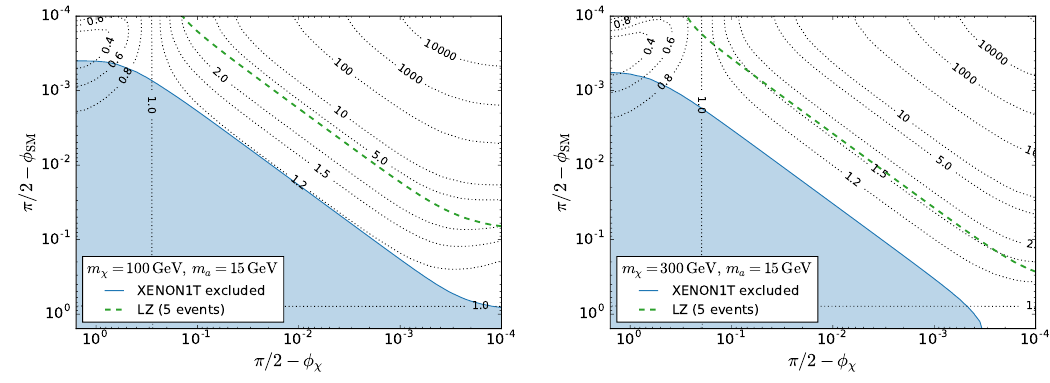
Figure 5 . Direct detection constraints as a function of the CP-violating phases (cid:30) both panels we have (cid:12)xed g (cid:31) = g SM = 1 and (cid:21) ah = 0. The dotted lines indicate the ratio of the predicted number of events in LZ when including both tree-level and loop-level diagrams and when only including tree-level diagrams. This ratio can be smaller than unity due to destructive